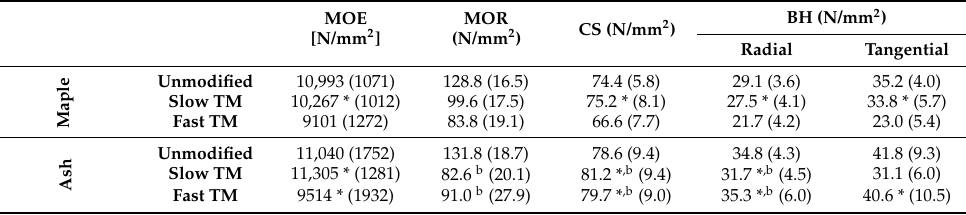
Table 5. Mechanical properties of unmodified and thermally modified maple and ash wood.